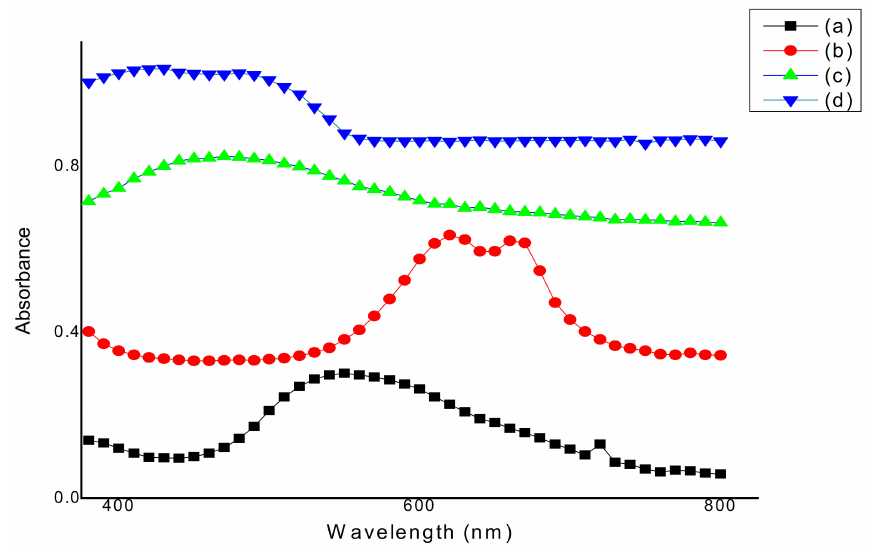
Figure 1. Graphical representation of spectrophotometric analysis of ( a ) Foron EBL blue, ( b ) Torque blue PG, ( c ) Terasil brown 2RFL, and ( d ) Orange P 3 R dye before